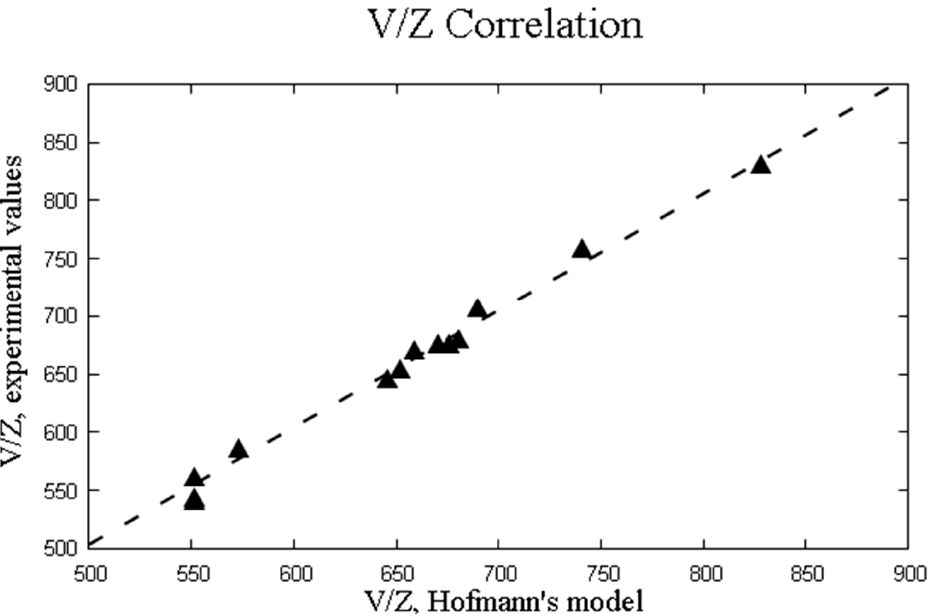
Figure 7. Molar volume correlation (values in Å 3 ) for the different crystal phases indexed in this paper, showing how good quality XRPD data may be uses in a predictive manner to assess the exact solvent nature and stoichiometry within the large class of Eltrombopag solvates. The dashed line refers to the linear fit defined by y = 1.007 x .